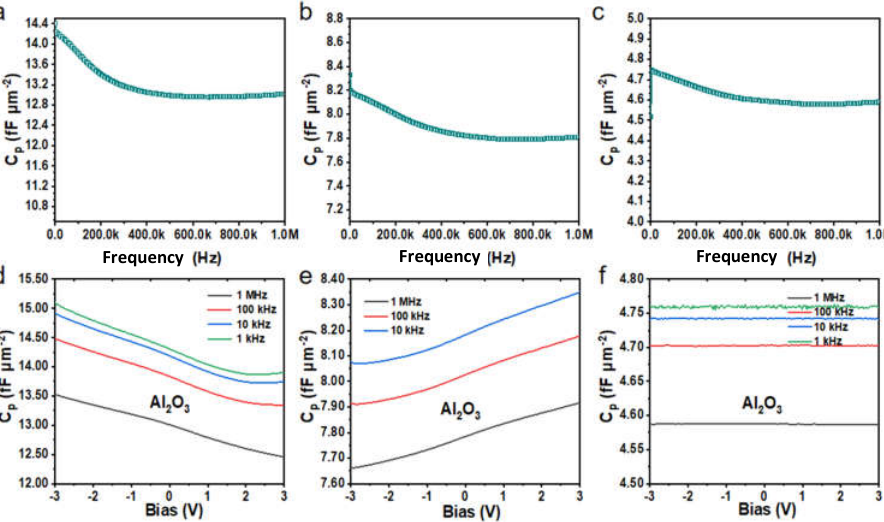
Figure 5. C - Q and C - V characteristic curves of 12.10 nm, 24.72 nm, and 49.73 nm Al 2 O 3 dielectric capacitors. ( a – c ) The C - Q characteristic curves of three thicknesses of dielectric capacitors, respectively. ( d – f ) The corresponding C - V characteristic curves of three thicknesses of dielectric capacitors at different frequencies.